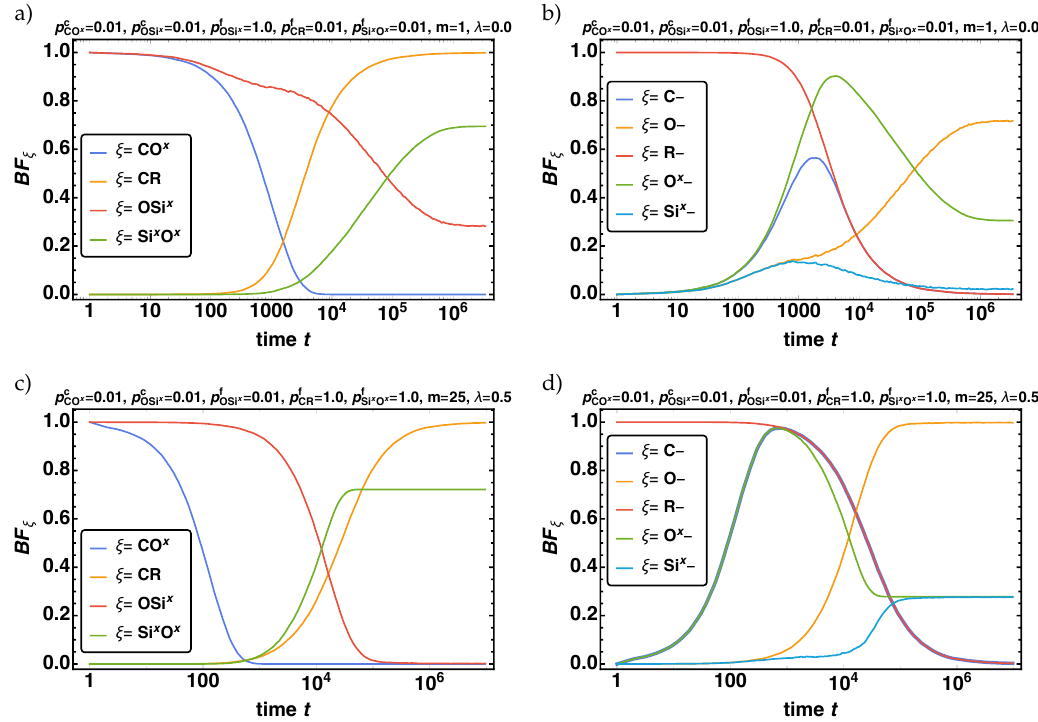
Figure 4. The time development of the bond fractions BF ξ of all bond vector types ξ = { CO x , OSi x , CR, Si x O x } in ( a , c ) and of the non-bonded reaction centers ξ = { C–, O–, R–, O x –, Si x – } in ( b , d ) are given for the two exemplary parameter combinations (I) and (II) ( a – d ). Note that in ( d ) the curve for ξ = C– is plotted thicker, as it falls on top of the curve for R– and O x –. In Figure 5 the resulting histograms for the BF ξ for ξ = { O–, Si x –, OSi x } for the parameter groups G λ (left column) and G OSi x (right column) are given. Note that the vertical dashed lines indicate the averaged bond fraction BF ξ of the corresponding parameter groups G ( i ) . For all three cases ξ = {